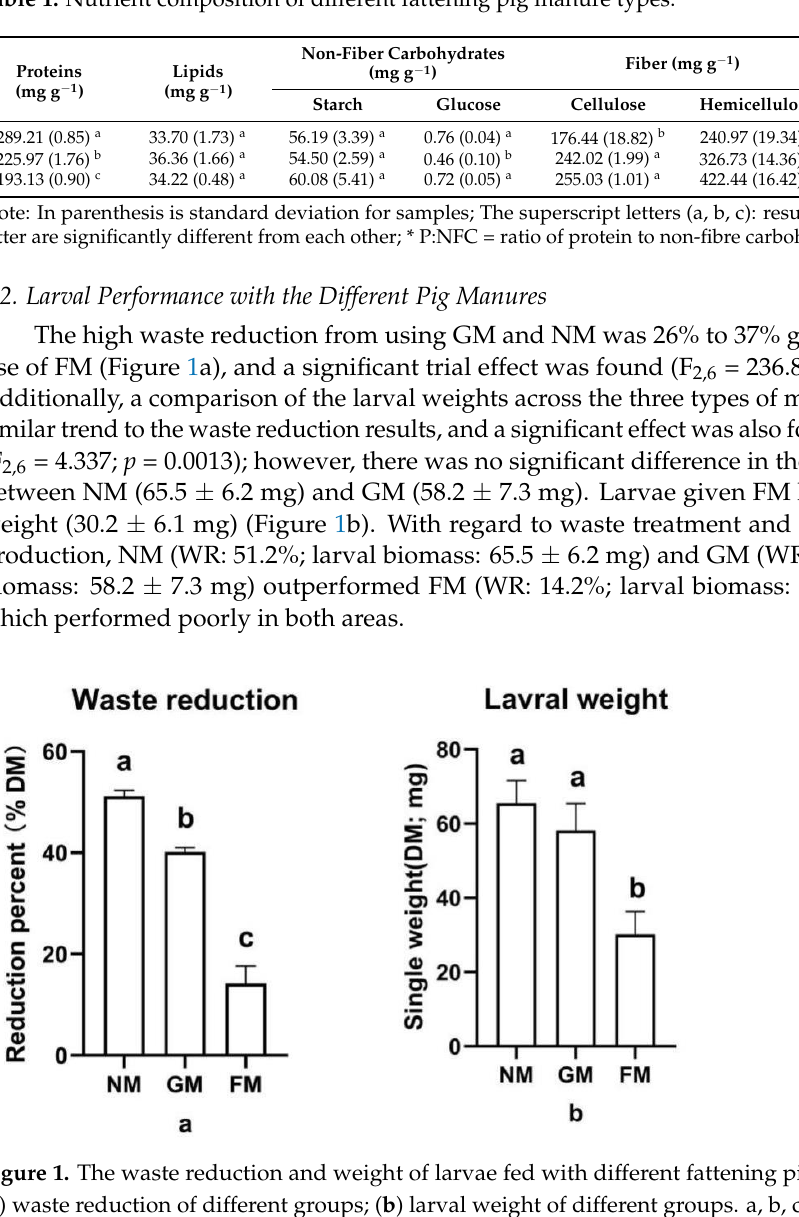
Table 1. Nutrient composition of different fattening pig manure types.